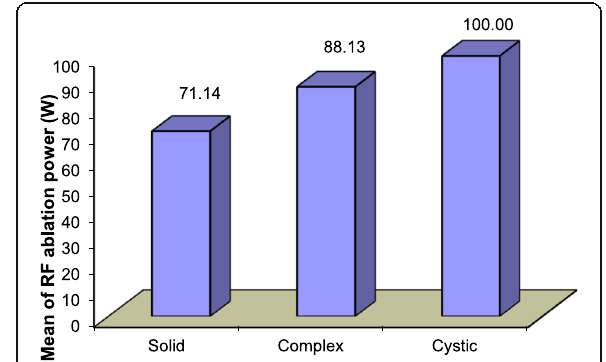
Fig. 7 The more cystic component of the nodule the more RF ablation power needed